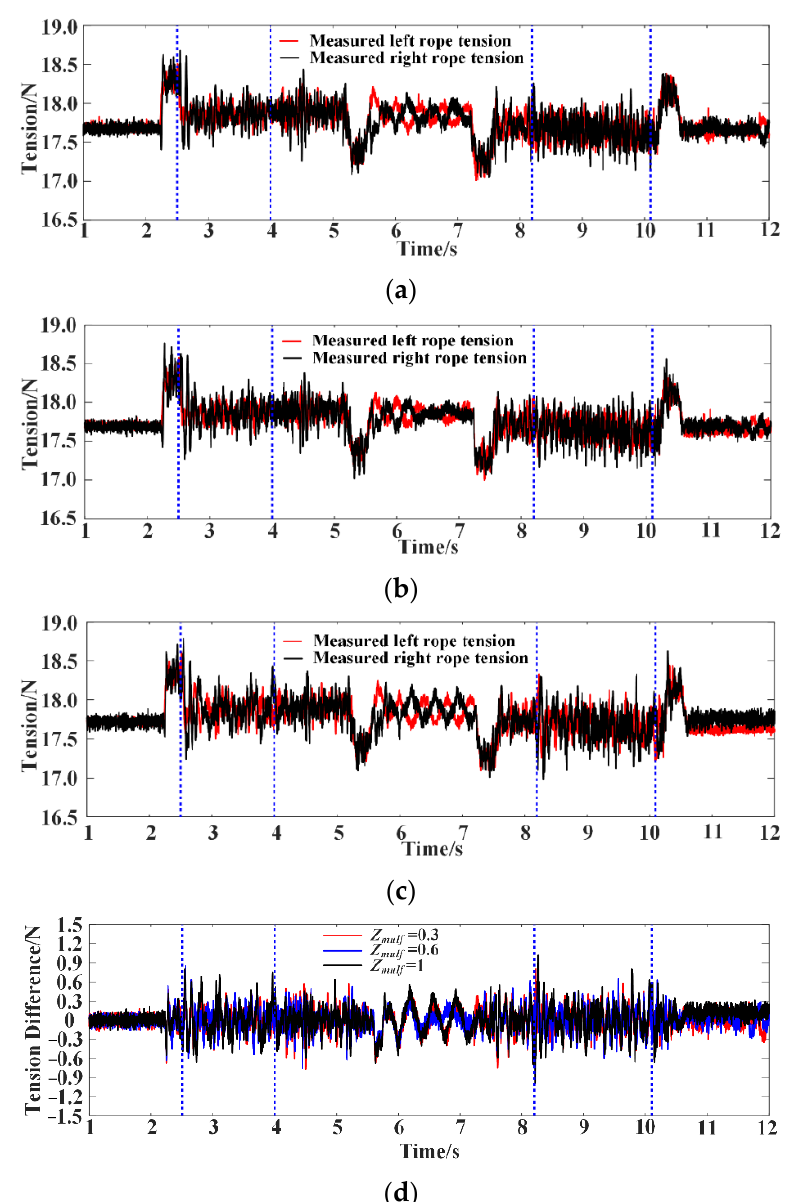
Figure 10. Measured rope tension and tension difference under fault condition with AFODST: ( a ) Z mulf = 0.3; ( b ) Z mulf = 0.6; ( c ) Z mulf = 1; ( d ) Tension